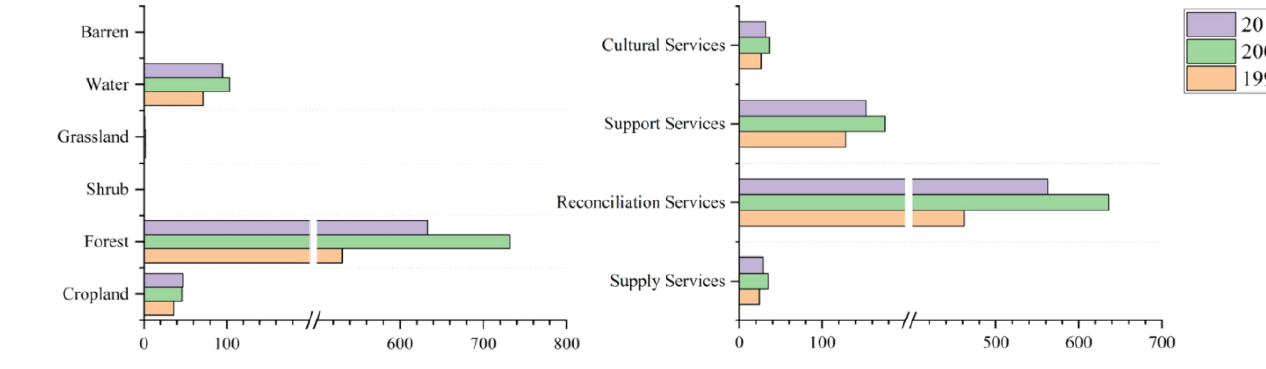
Figure 3. Temporal evolution of ESV in Hainan Island from 1999 to 2017.